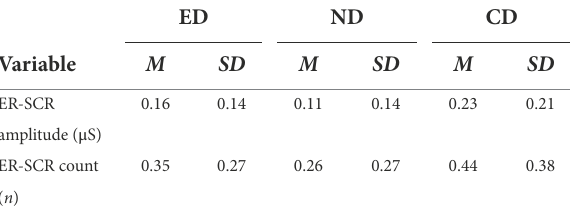
TABLE 2 Mean ER-SCR amplitude, count, and standard deviations for design ( n = 18).